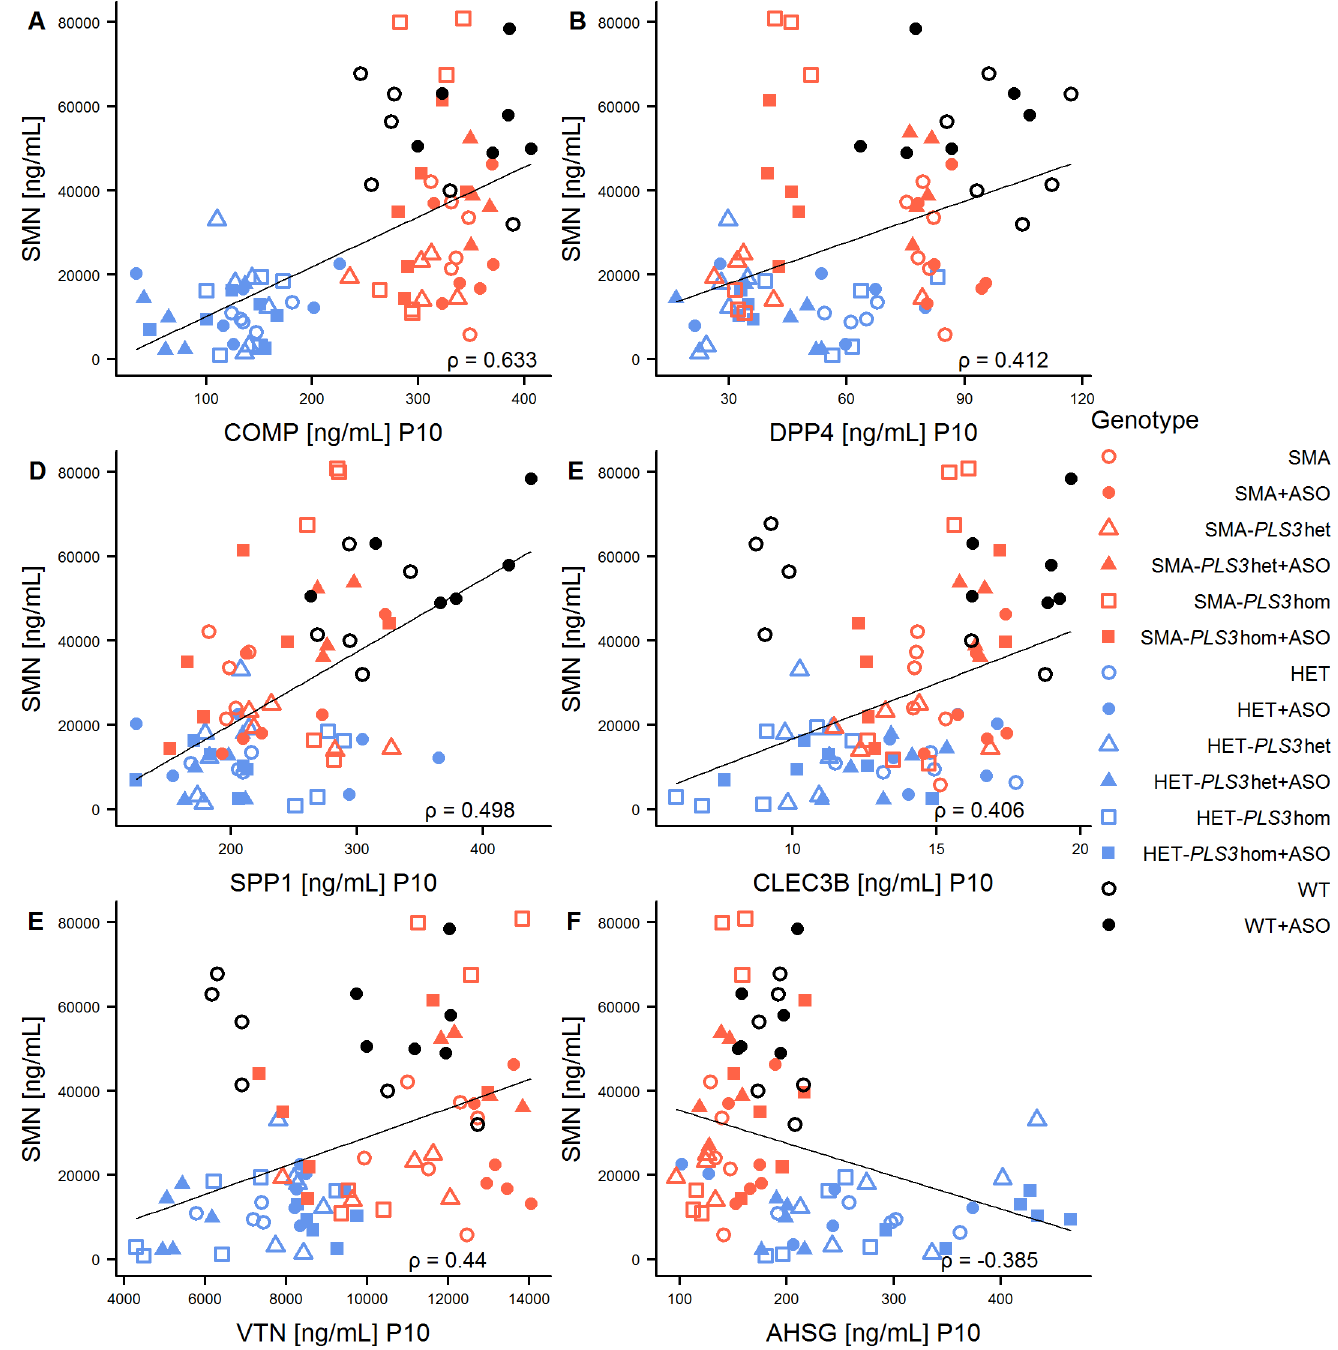
Fig 5. Correlations of SMN plasma protein with the concentration of biomarkers at P10. (A) COMP, (B) DPP4, (C) SPP1, (D) CLEC3B, (E) VTN and (F) AHSG. A linear model is fitted into the plots and the Spearman’s Correlation Coefficient ρ for each linear model is given in S8 Table.